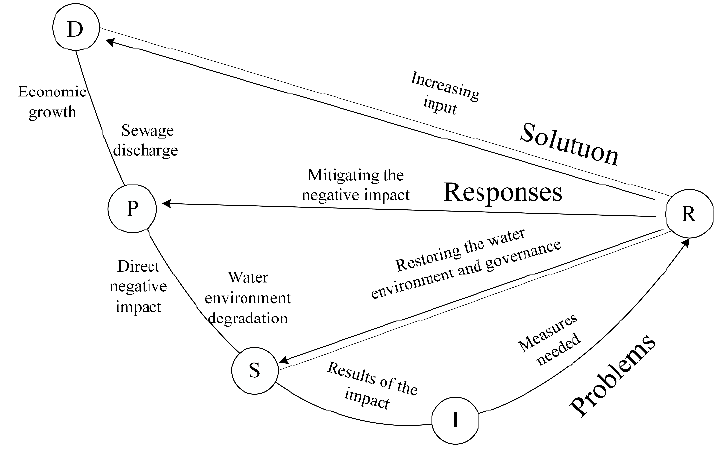
Figure 2. The DPSIR model of water environment governance performance.